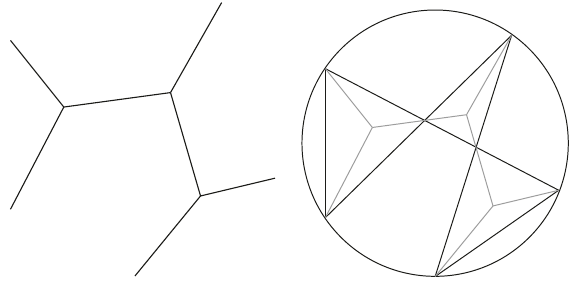
Figure 7 . Map between Feynman diagram and disk